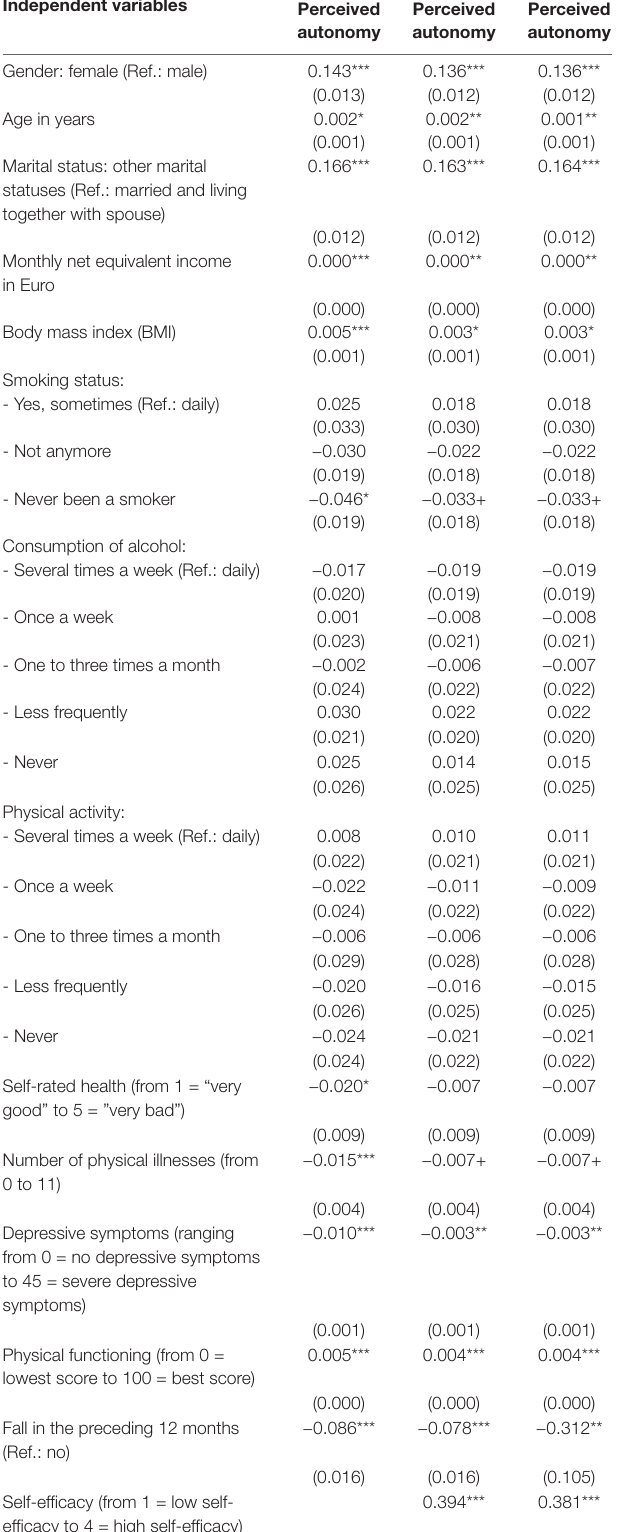
TABLE 2 | Determinants of perceived autonomy. Results of multiple linear regression analysis (German Ageing Survey, fifth wave). Independent